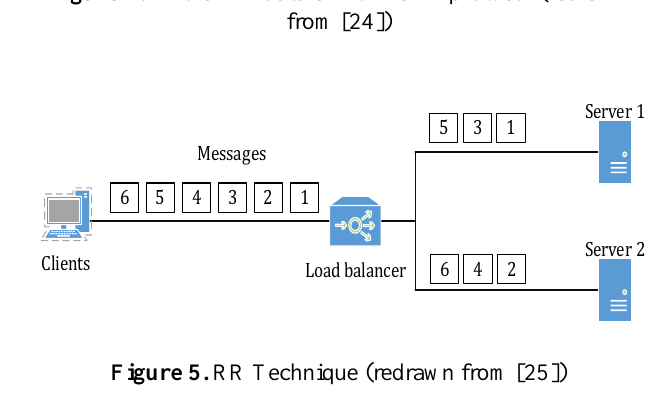
Figure 4. Two SLB routers with HSRP protocol (redrawn